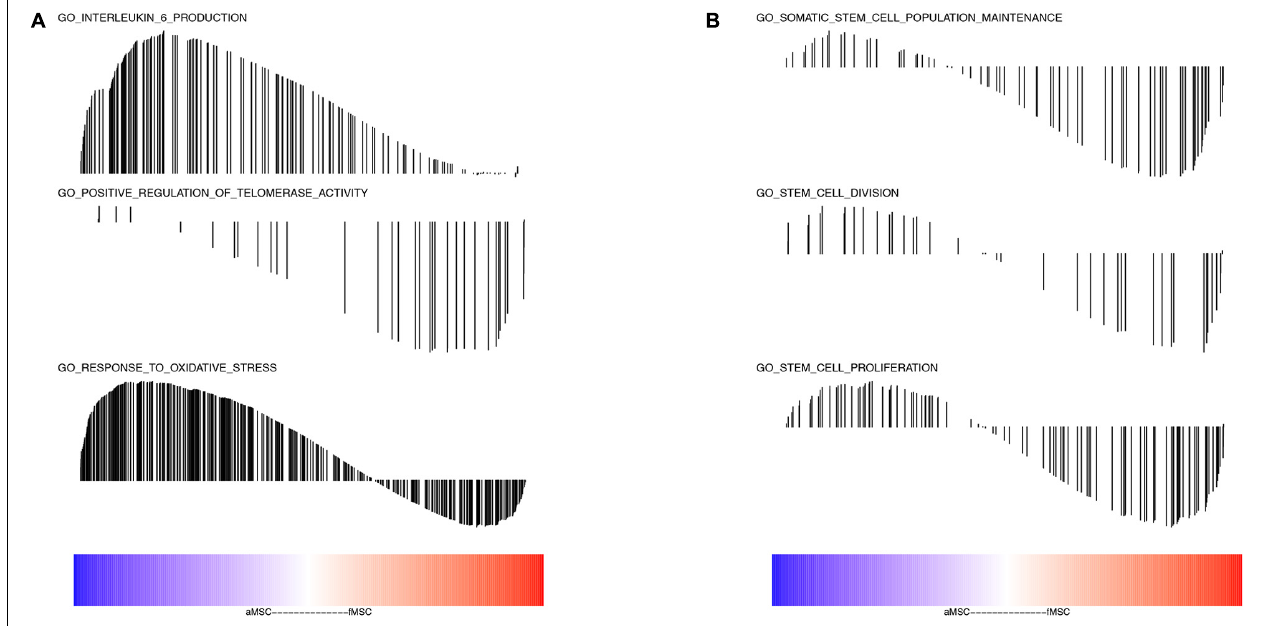
FIGURE 3 | Analyses of gene sets related to aging and stem cell self-renewal. (A) Interleukin 6 production (NES = 1.939, FDR q-value = 0.019); positive regulation of telomerase activity (NES = –1.616, FDR q-value = 0.021); response to oxidative stress (NES = 1.4371426, FDR q-value = 0.076). (B) Somatic stem cell population maintenance (NES = –1.378, FDR q-value = 0.069); stem cell division (NES = –1.207, FDR q-value = 0.158); stem cell proliferation (NES = –1.266, FDR q-value = 0.046). The color bar indicates the sort order of genes (blue represents up-regulated in aMSC group and red represents up-regulated in fMSC group). The location of vertical bar indicates the occurrence of that gene within the ranked list and the height of the bar indicated the enrichment